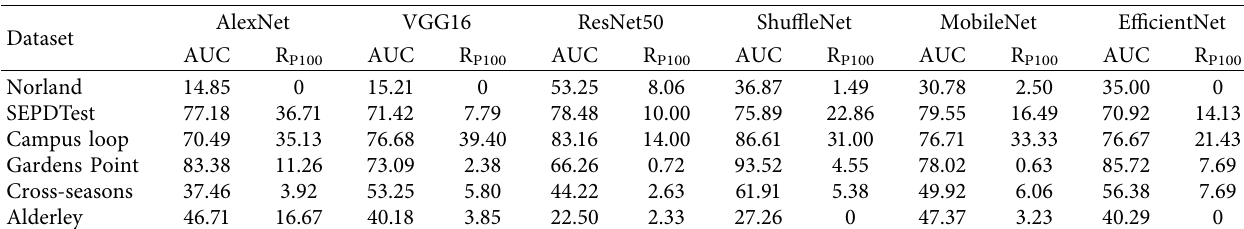
Table 4: Te values of AUC and R P100 for 6 of-the-shelf CNN-based